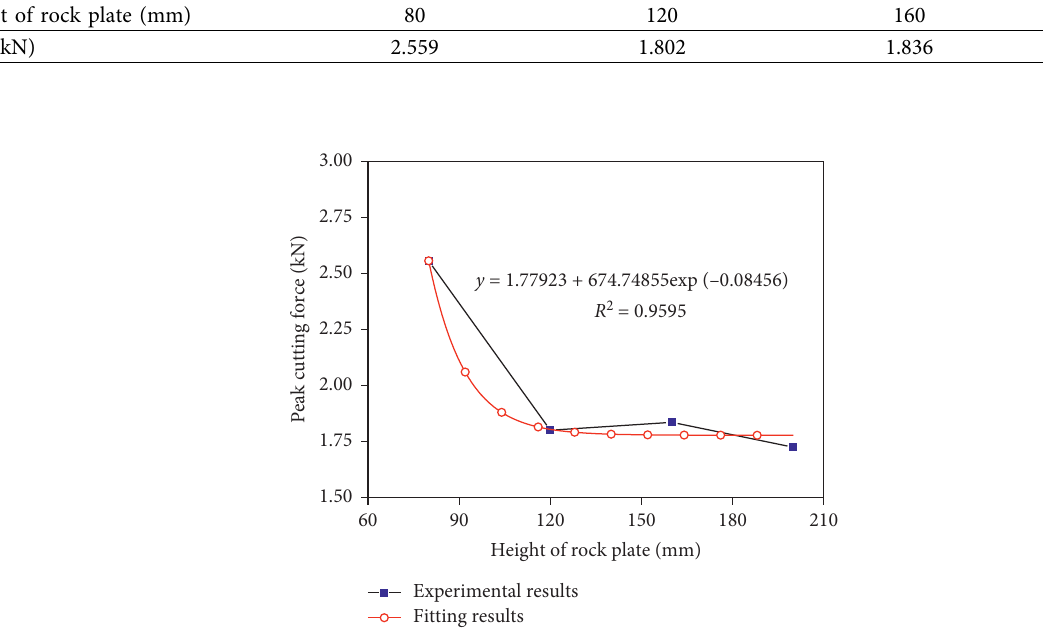
Figure 22: The relationship between PCF and height of rock